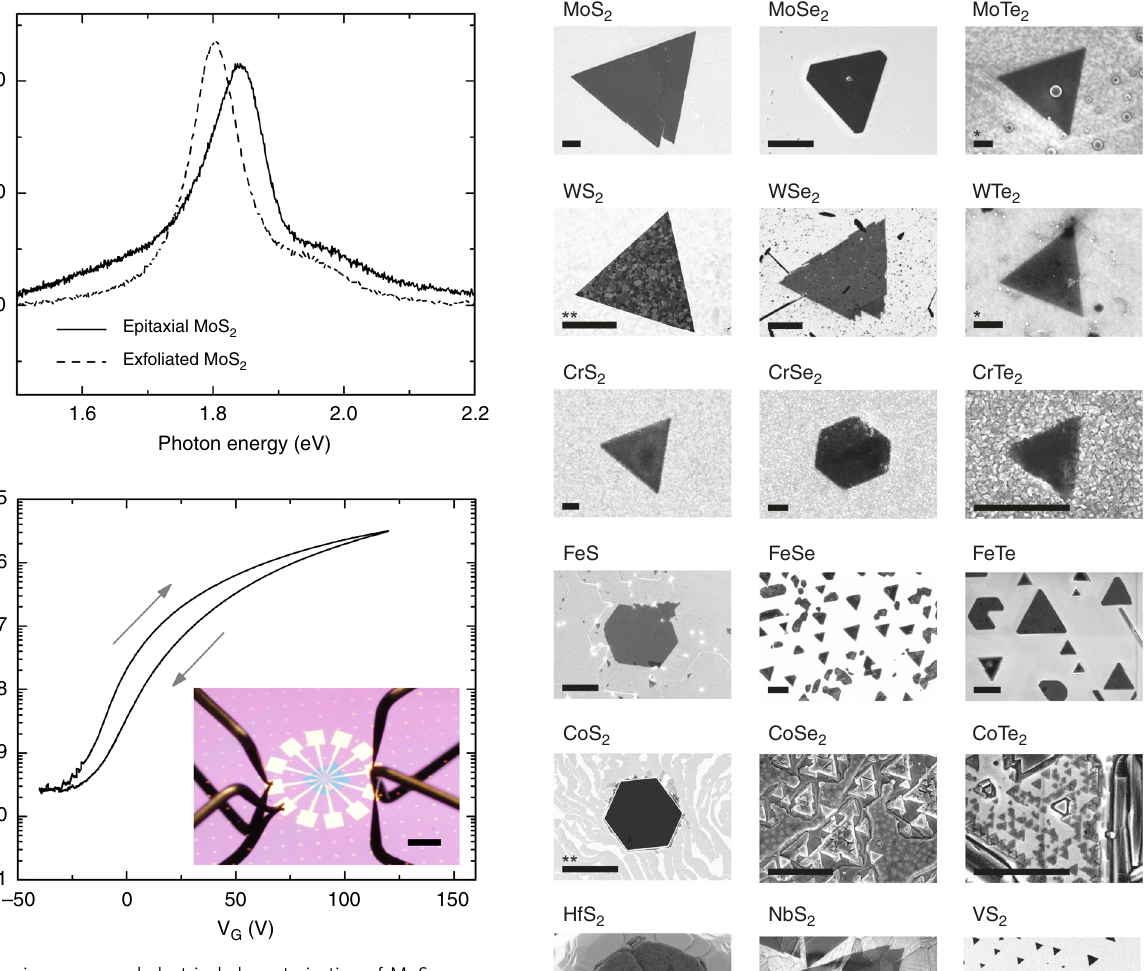
Fig. 4 Photoluminescence and electrical characterisation of MoS 2 . (solid line) vs. mechanically exfoliated monolayer MoS 2 (dashed line).